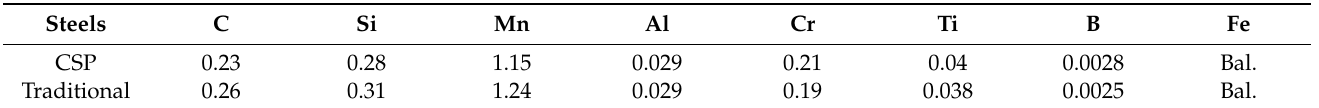
Table 1. Chemical composition of 1500 MPa grade hot-stamping steel after traditional and CSP processes